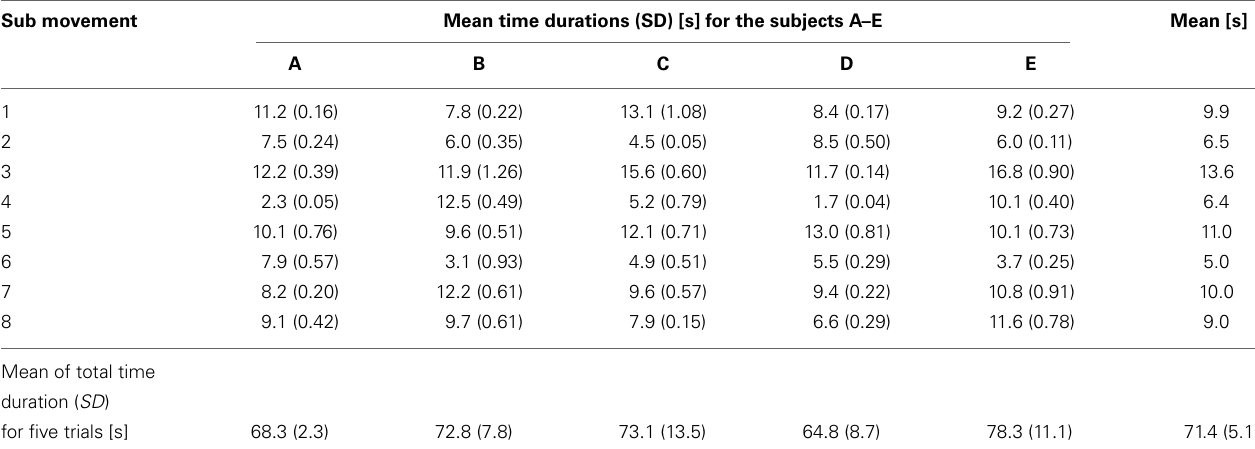
Table 4 | Mean time durations along with their standard deviations for each sub movement defined in Figure 5 and each subject. Sub movement Mean time durations (SD) [s] for the subjects